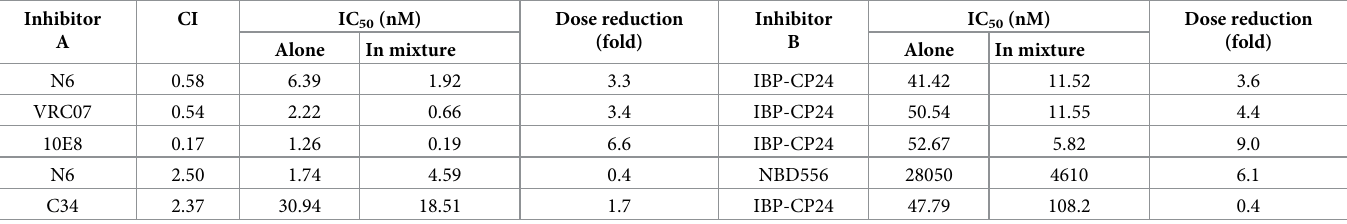
Table 5. Inhibitory activity of IBP-CP24 (C34 as a control) or bNAbs (NBD556 as a control) when used alone or in combination against infection HIV-1 IIIB or JR-CSF a . Inhibitor